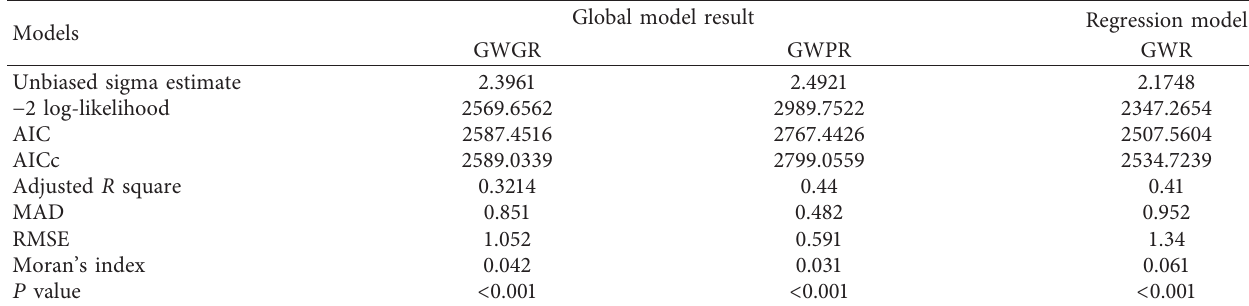
Table 8: Comparison and fitted goodness